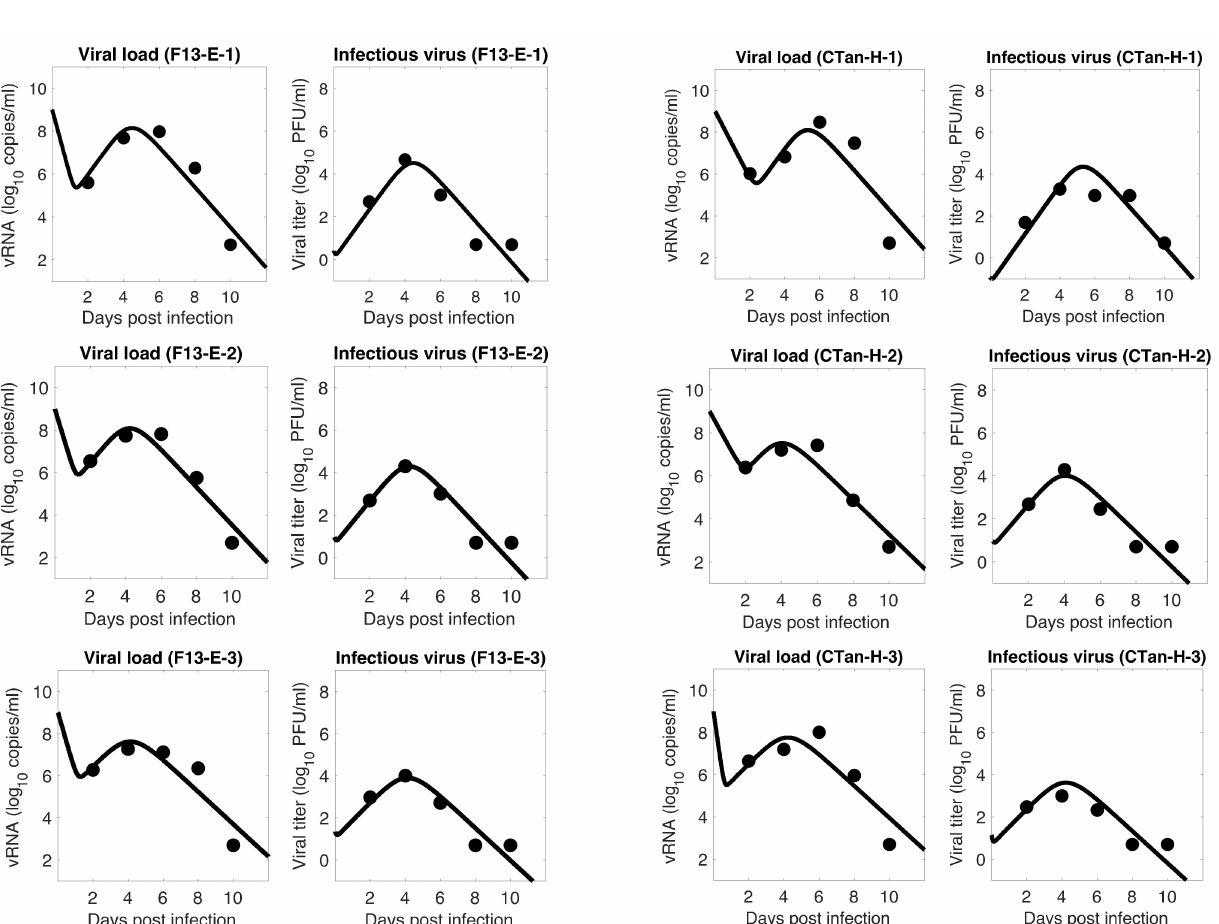
Figure 1. Model 1 fitting to the data. Prediction of the viral dynamics model 1 (solid line) along with the data (filled circle) containing the total viral load (RNA copies per mL) and the infectious virus titer (PFU per mL), collected from ferrets infected with F13-E SARS-CoV-2 and CTan-H